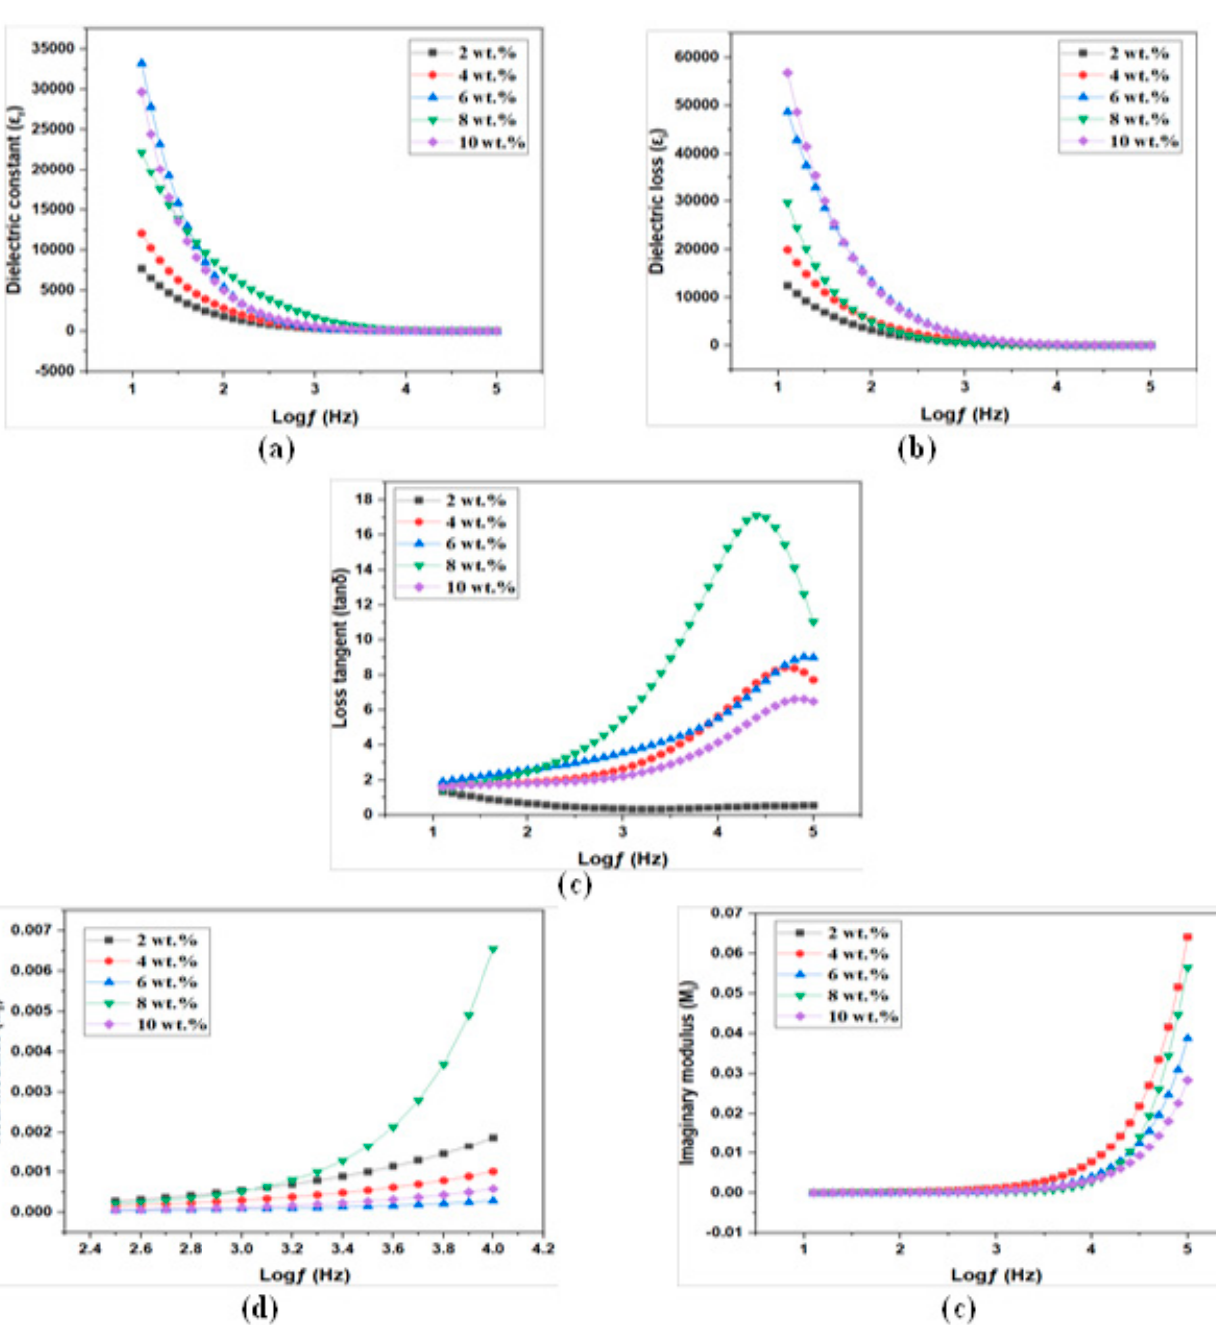
Figure 8. Dielectric spectra of MC/PC/NH 4 Cl/ZnO films; ( a ) Real part of complex permittiv- ity ( b ) Imaginary part of complex permittivity ( c ) Loss tangent ( d ) Real part of complex modulus ( e ) Imaginary part of complex